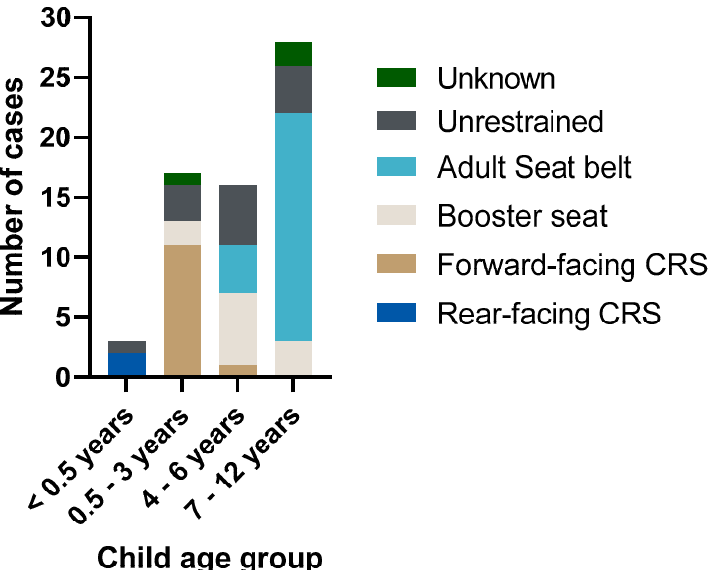
Figure 3. Restraint status for child age ranges in NSW child passenger deaths, 2007–2016.